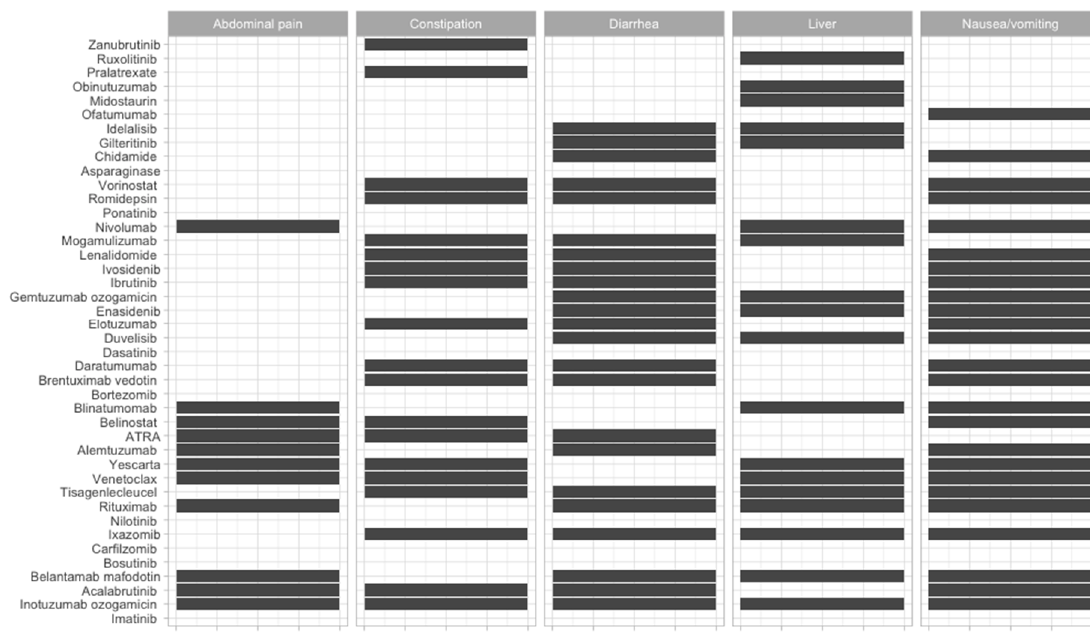
Figure 7. Gastrointestinal side-effects of FDA-approved and non-approved drugs for hematological disorders.